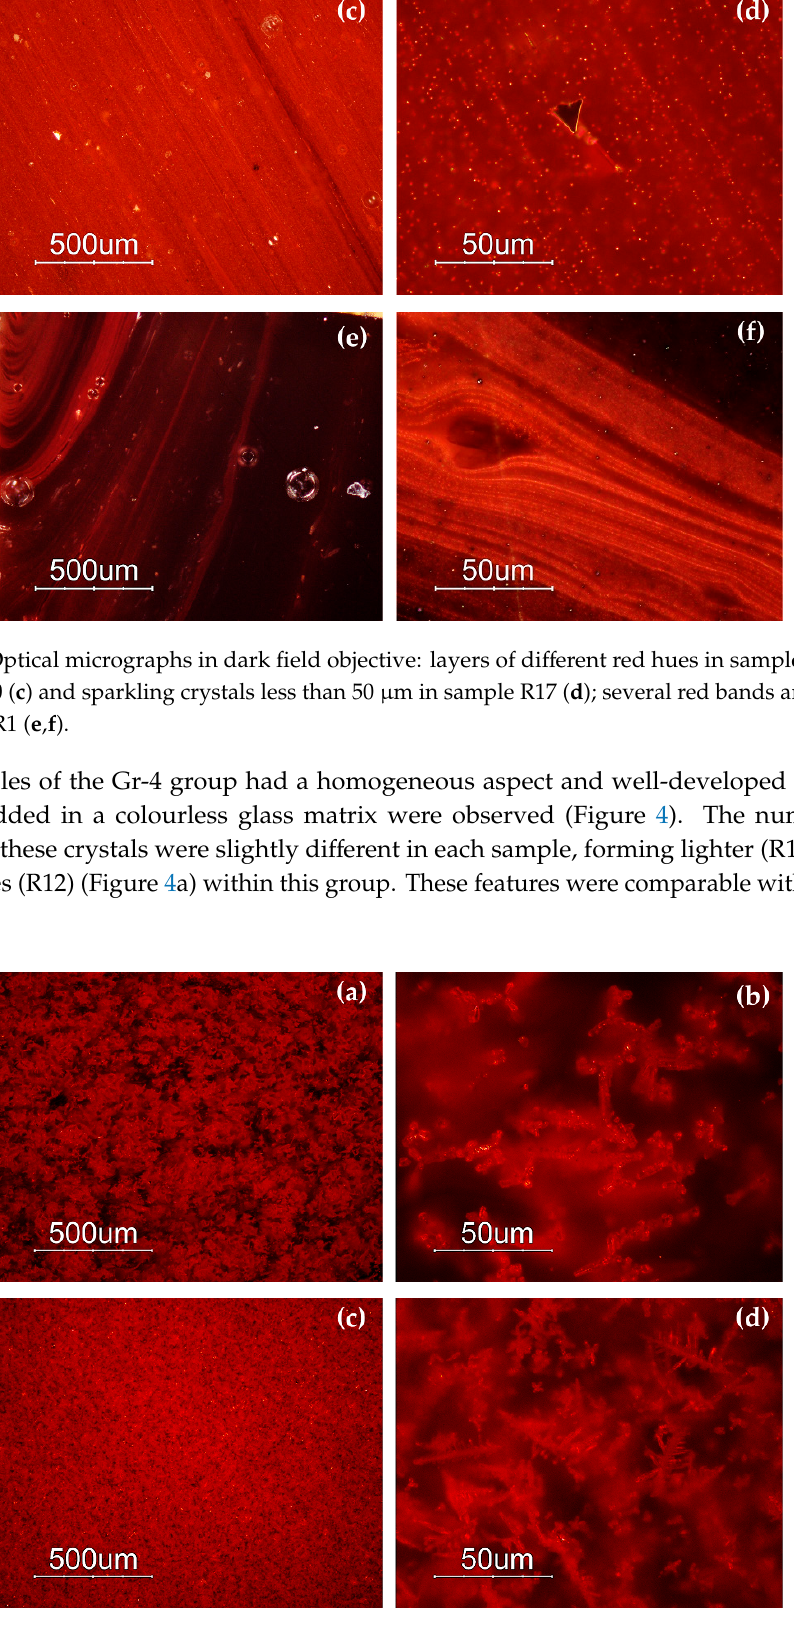
Figure 4. Optical micrographs in dark field objective: dendritic crystals embedded in the glass matrix in sample R12 ( a , b ) and R13 ( c , d ).